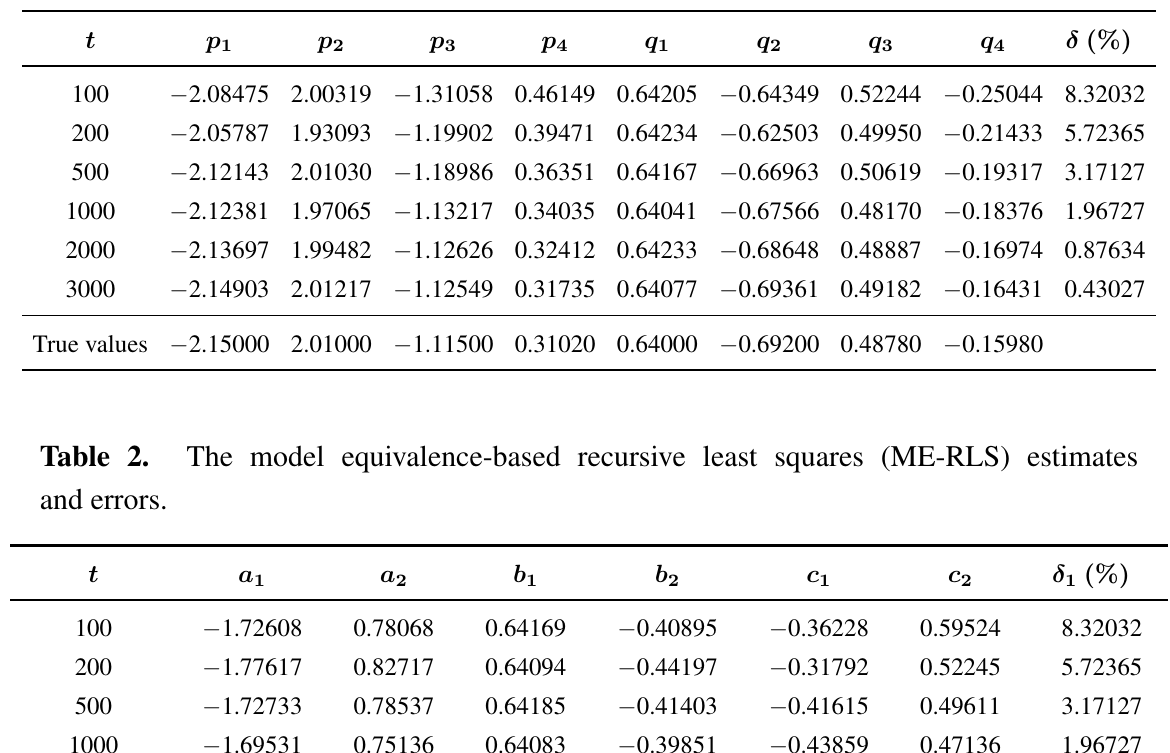
Table 1. The estimates and errors of the parameters p